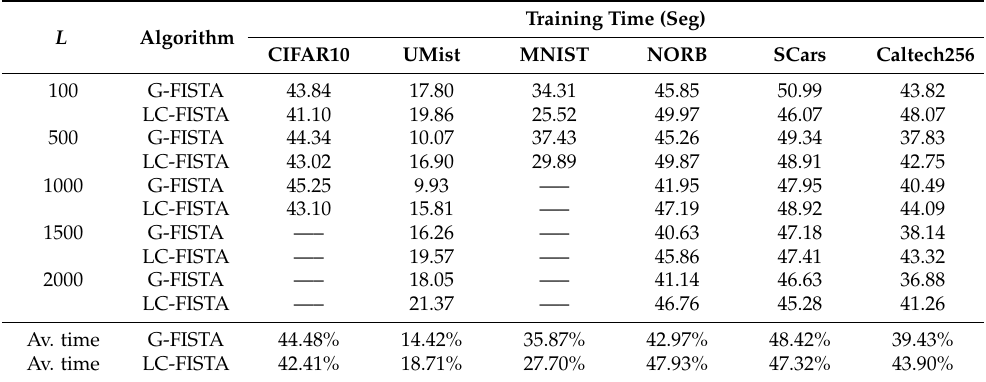
Table 9. Average speeds of the G-FISTA and LC-FISTA algorithms compared with FISTA for training of the